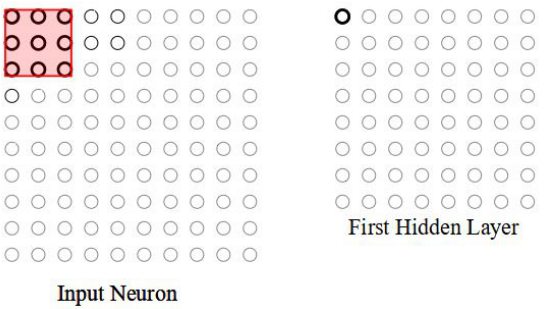
Figure 2. Local receptive field in the top-left corner to connect to first hidden neuron.